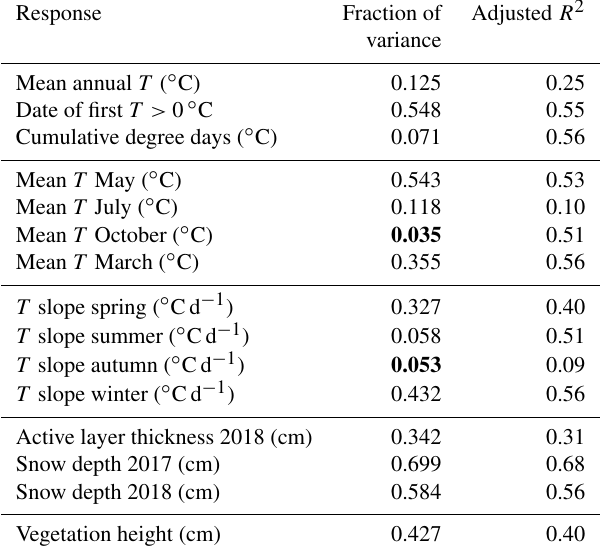
Table 2. Relationship of vegetation and topsoil temperature ( T ) characteristics, active layer thickness, snow depth, and vegetation height expressed by the fraction of variance explained by vegeta- tion type in a statistical model (lm(response ∼ period + vegetation type)) and the adjusted R 2 ; complete data set accounting for the measurement period of topsoil temperature first; results which are not significant at a level of 0.05 are shown in